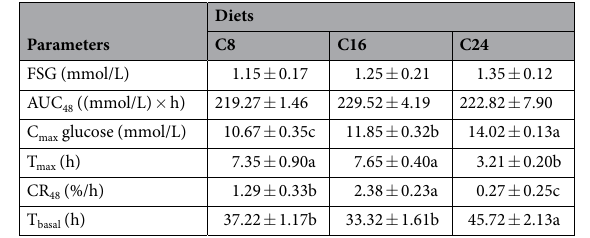
Table 2. Analyzed parameters in the glucose tolerance test. Values of fasting serum glucose are presented as mean ± S.D., n = 3 (8 fish/replicate) and other values are presented as mean ± S.D., n = 3 (3 fish/replicate). Values followed by different letter in the same row are significantly different ( P <